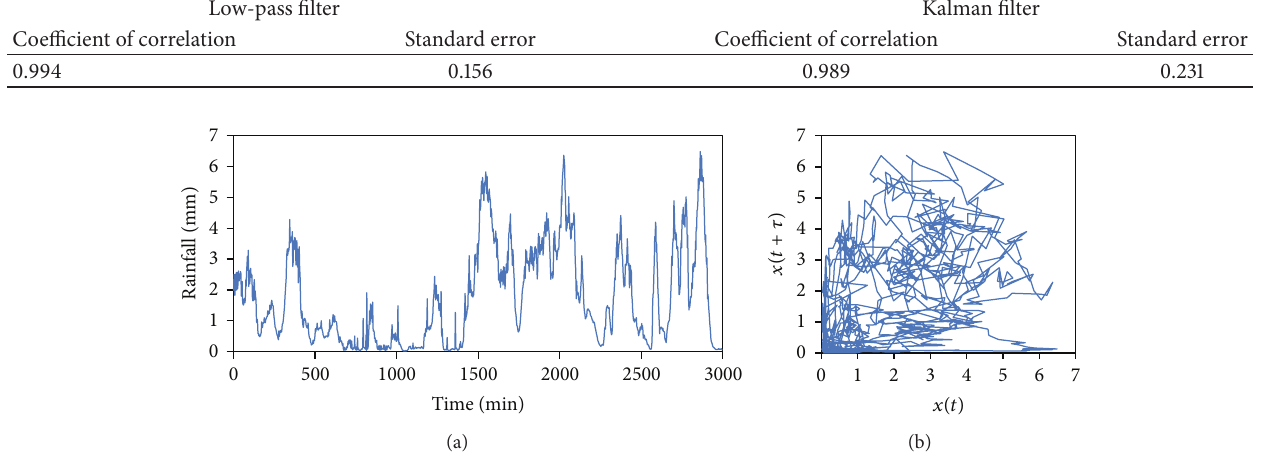
Figure 5: The time series (a) of radar rainfall and its attractor (b).